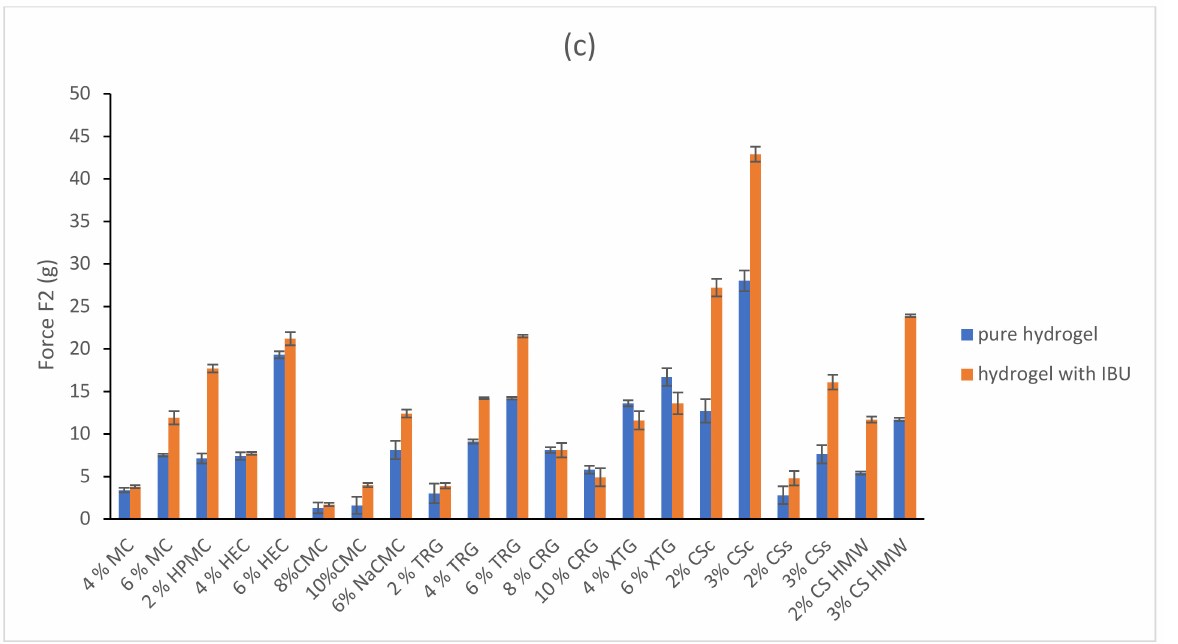
Figure 3. Comparison of hardness ( a ), adhesiveness ( b ), and minimal retracting force ( c ) of chosen hydrogels without IBU and containing